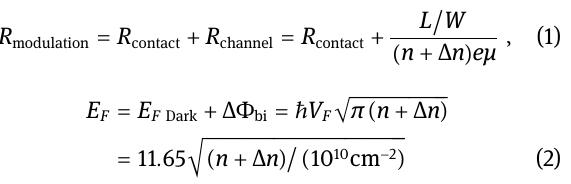
Figure 4: (a) Response time of the GSOI device versus the vertical voltage, error bars of T on and T off represent the rising and falling time, respectively. (b) 3 dB bandwidth measurement results of the GSOI device under 532 nm illumination when V g = 0 V and V g = 30 V, respectively. (c) Simulated distribution of electrons in top-silicon when V g = 0 V. (d) Simulation concentration gradient formed by electrons in top-silicon when V g = 30